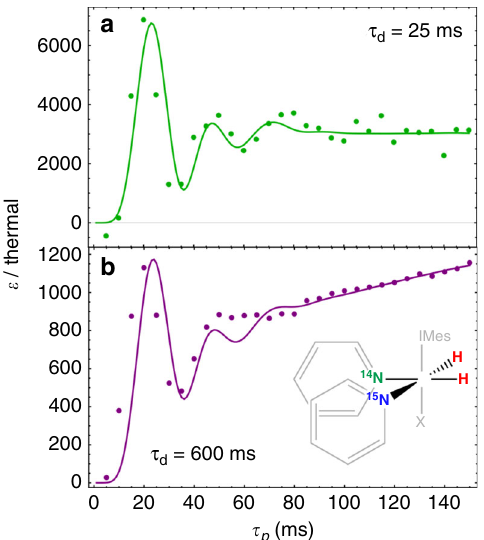
Fig. 3 Dynamics of isotopically dilute samples. Samples have fi nal pyridine concentrations of 50 mM. a DARTH dynamics of natural abundance pyridine with delays τ d = 25 ms, making the dynamics quasi-CW. b DARTH dynamics of 15% labeled pyridine with delays τ d = 600 ms. Data are shown fi t to numerical simulation with an average PTC lifetime of 20